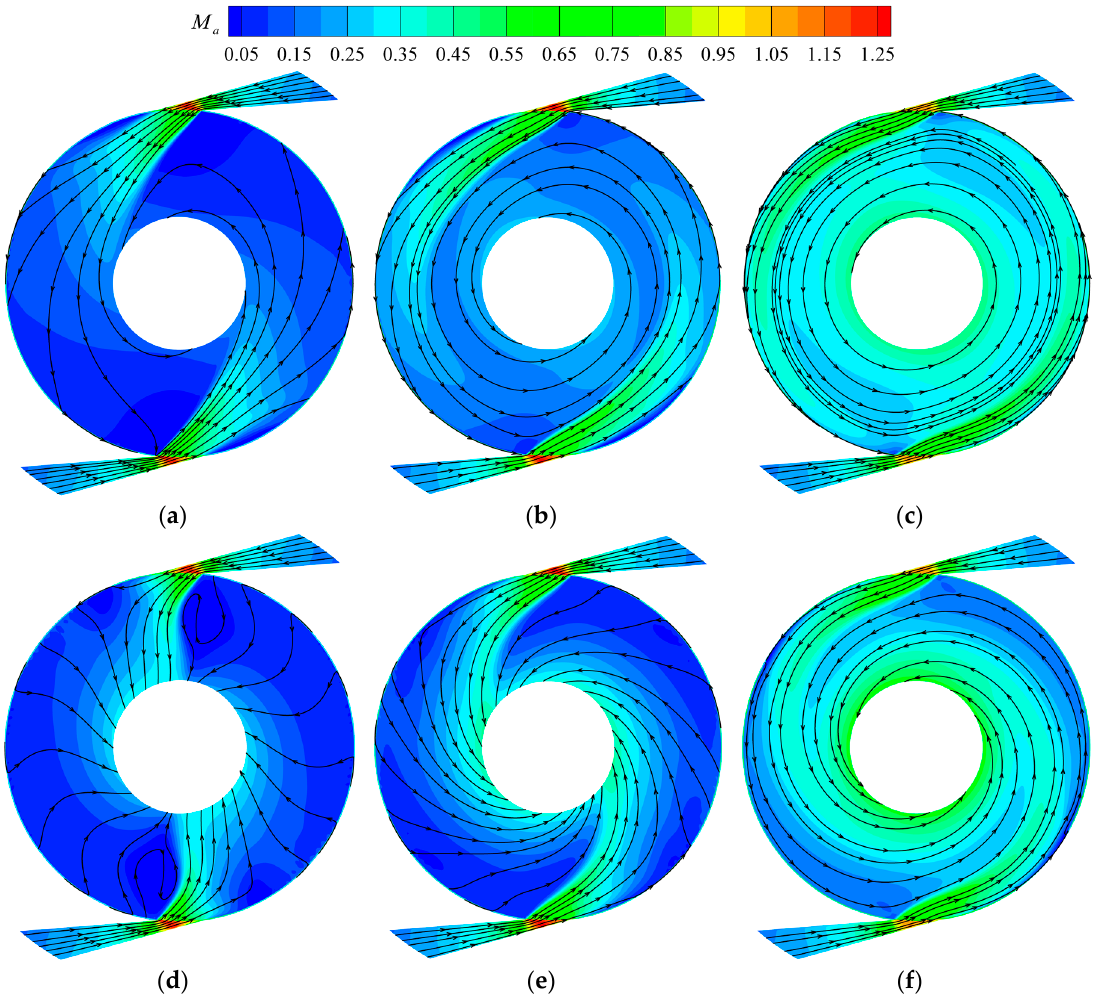
Figure 11. Mach number contours and streamlines on the mid-sections of DCs 1 and 3 for the one-to-one turbine cases with different disc spacing distance at 30,000 r/min: ( a ) DC1 for Case 1-0.3; ( b ) DC1 for Case 1-0.5; ( c ) DC1 for Case 1-1; ( d ) DC3 for Case 1-0.3; ( e ) DC3 for Case 1-0.5; and ( f ) DC3 for Case 1-1.